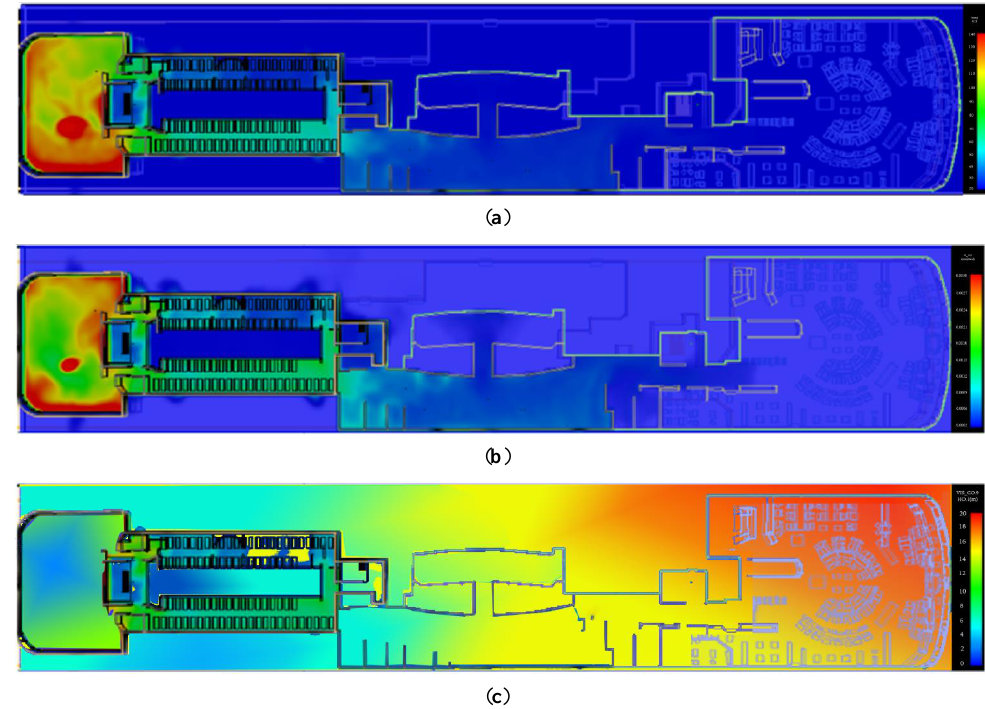
Figure 8. ( a ) Temperature cloud at 200 s; ( b ) CO volume fraction cloud at 200 s; ( c ) smoke visibility cloud at 200 s.